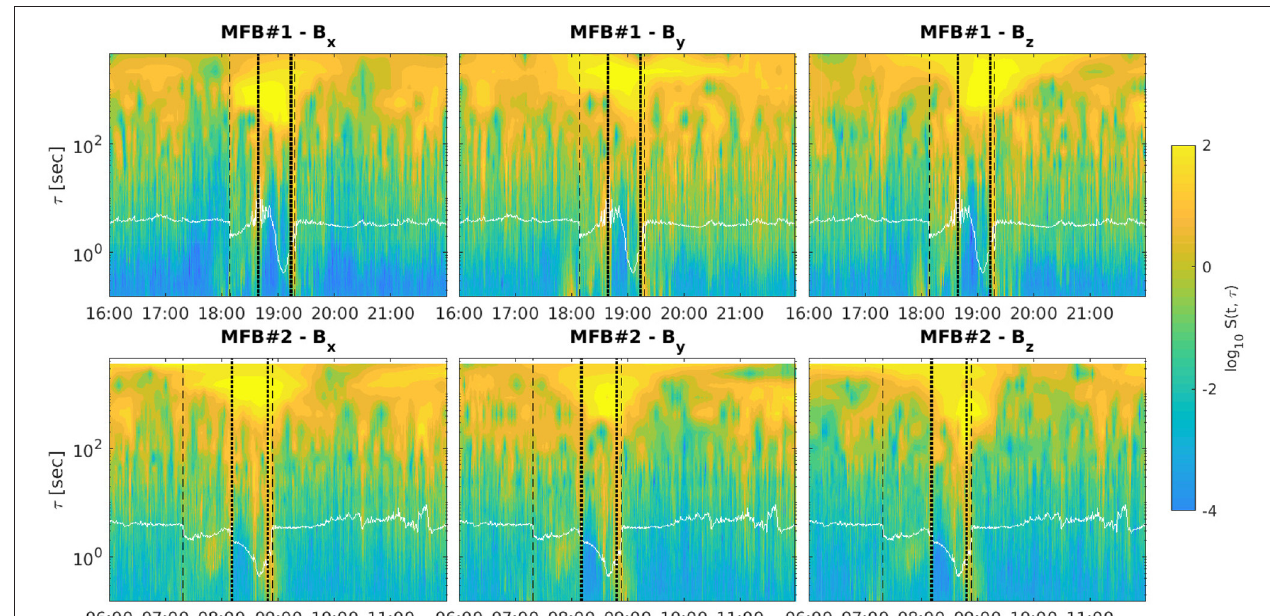
= 1 / f c , while the vertical dashed and dotted lines refer to i i